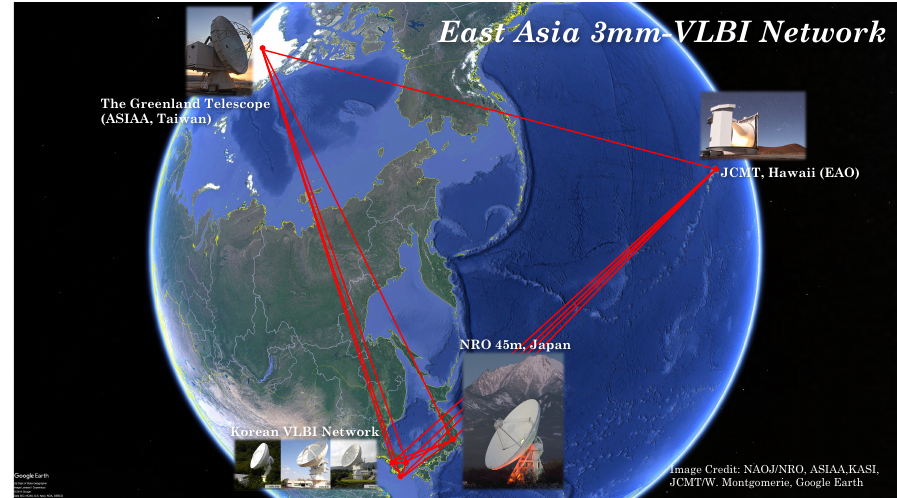
Figure 10. East Asia 3 mm VLBI Network.